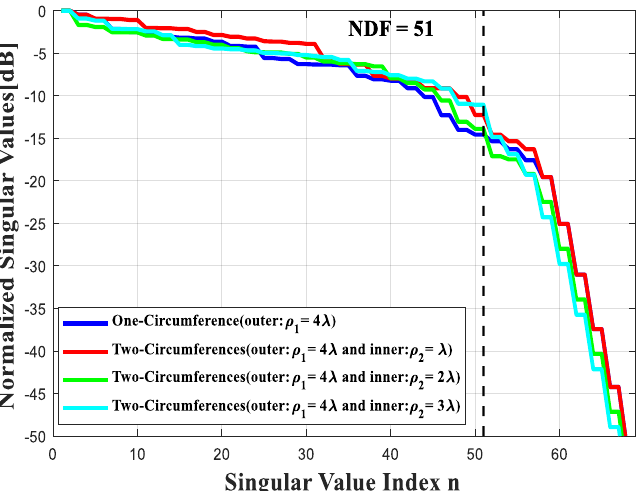
Figure 2. Comparison of the behavior of the normalized singular values of the relevant operator of the inverse source problem for one and two circumferences cases.